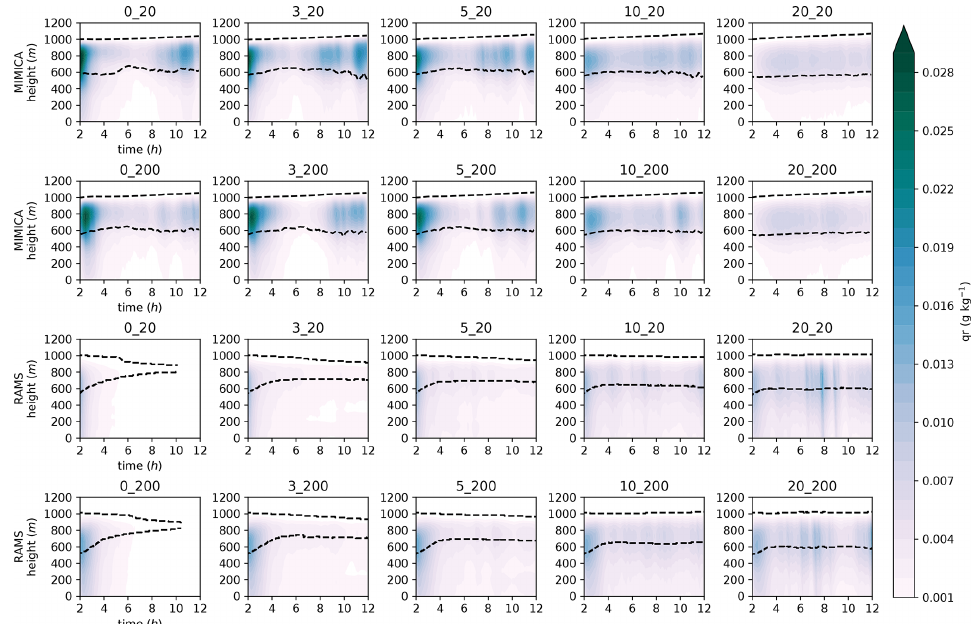
Figure A4. Rain mixing ratio (qr) for the MIMICA and RAMS simulation sets. The first 2h of simulations, considered as the spin-up period, are excluded. For figure clarity, the plot titles have been abbreviated; the first number refers to the accumulation mode and the second to the Aitken mode concentration in cubic centimetres, i.e. 0_20 refers to AC0_AK20. Black dashed lines represent the cloud top and cloud base heights.